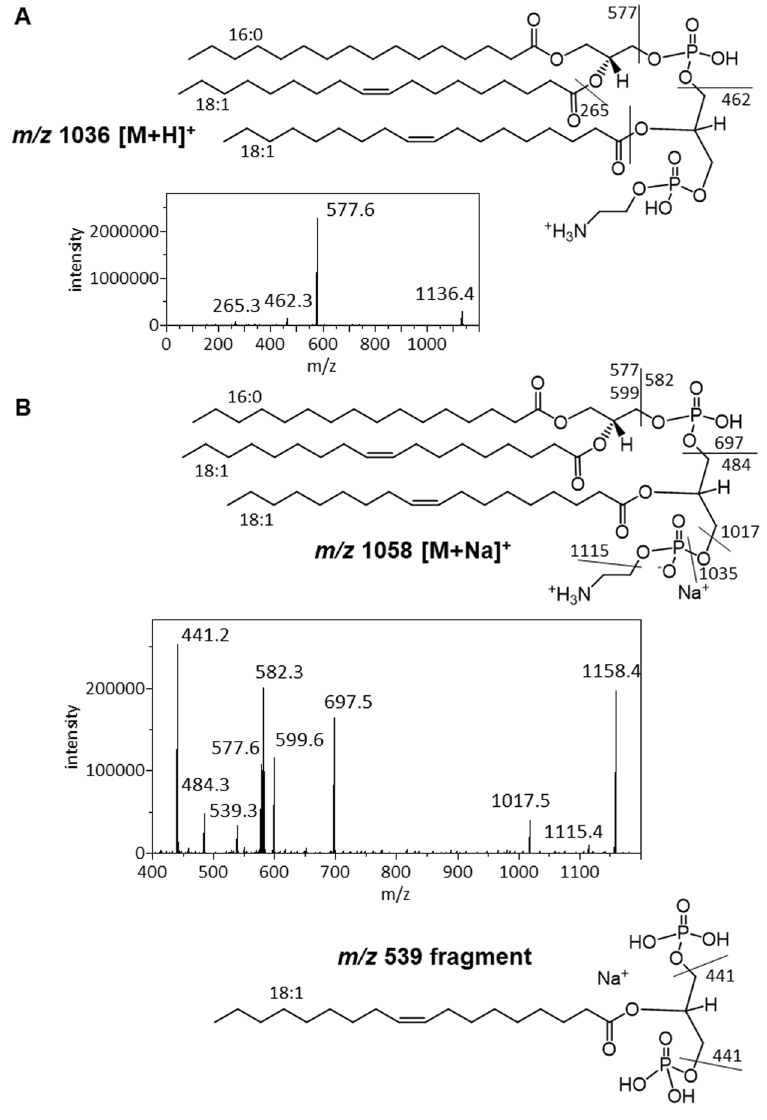
Figure 6. Dissociation and MS/MS spectrum of PAGPE cations. ( A ) Dissociation and MS/MS spectrum of the m/z 1136 protonated ion. ( B ) Dissociation and MS/MS spectrum of the m/z 1158 protonated ion. Two magnified areas of the spectrum are also